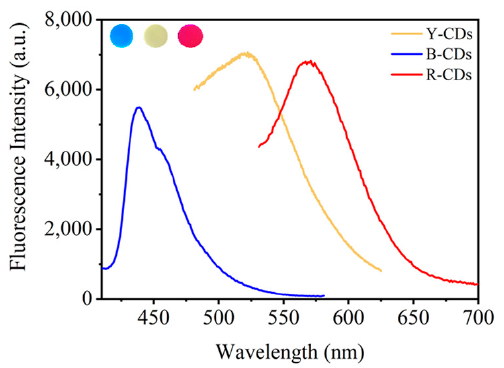
Figure 7. Fluorescence emission spectra of B-CDs/PVA, Y-CDs/PVA, R-CDs/PVA films. (Insert: The photographs of CDs/PVA films under UV